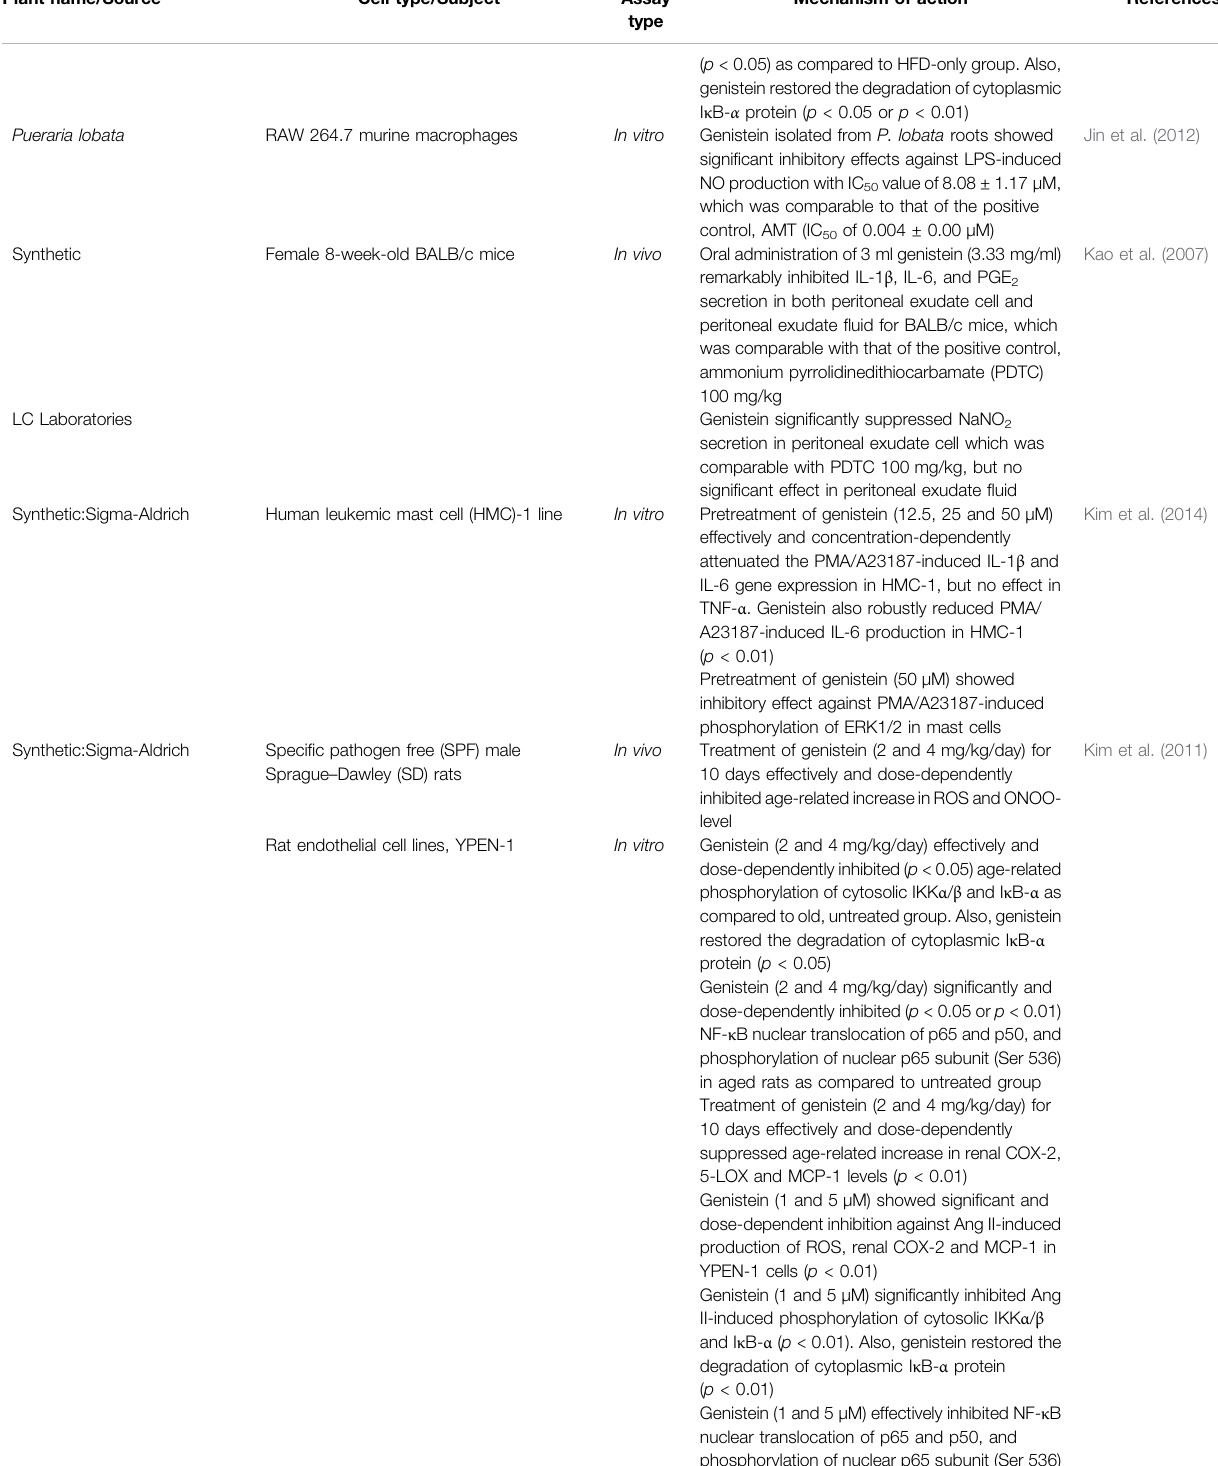
TABLE 1 | ( Continued ) Genistein with potent anti-in fl ammatory